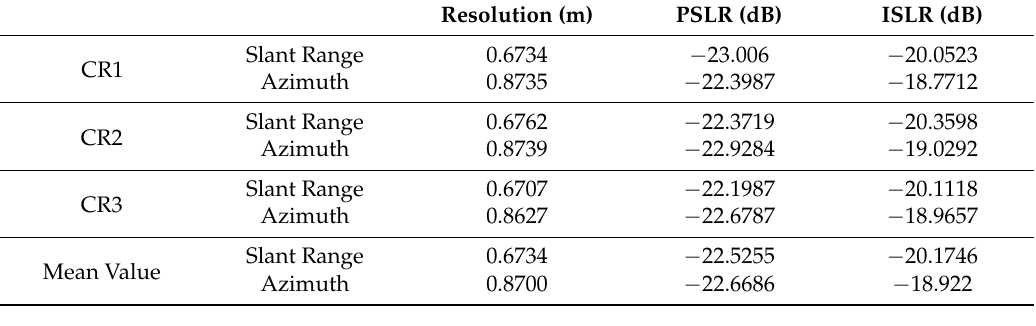
Table 4. Results after spotlight processor applied the enhancements.